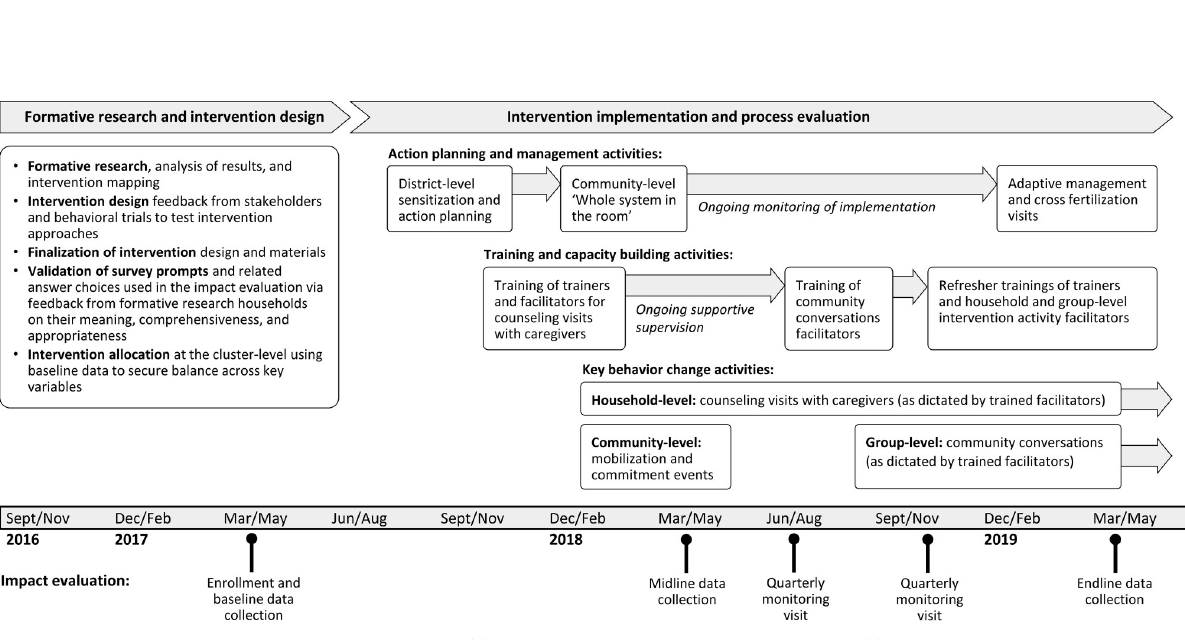
Fig 2. The Andilaye Trial consists of three major phases: (1) formative research and intervention design, (2) intervention implementation and process evaluation, and (3) impact evaluation. Kebele and household enrollment took place during baseline data collection (March to April 2017). Implementation of Andilaye intervention activities began in September 2017 and continued through midline data collection (March to April 2018), quarterly monitoring (June to July and November to December 2018), and endline evaluation (March to May 2019). See S1 Table for specific dates of the delivery of intervention activities. Midline data reflected at least 2 months since the start of household-level behavior change activities and 3 weeks since the completion of a catalyzing community-level mobilization and commitment event. Our endline data reflected the implementation of 14–15 months of household-level behavior change activities and 6–7 months of group-level behavior change activities (as dictated by trained activity facilitators) and 13–14 months since the community mobilization and commitment